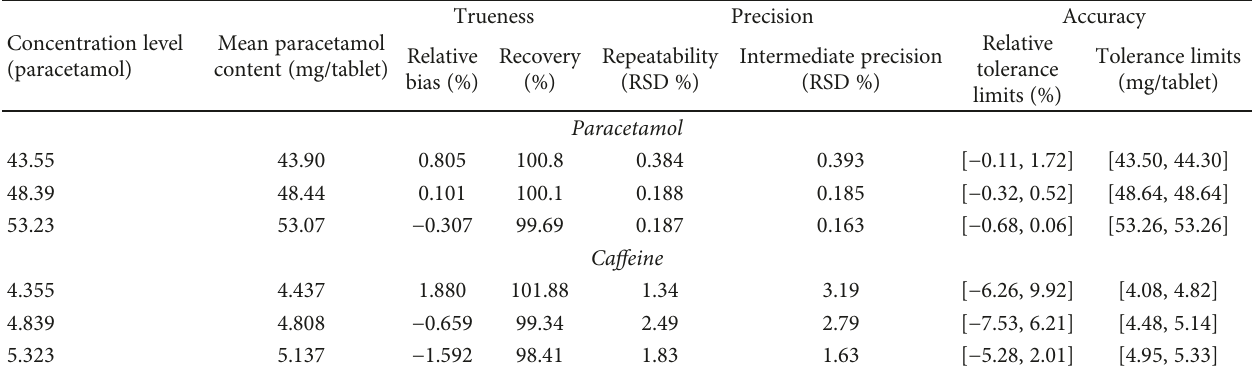
Table 4: Validation results of NIR method for paracetamol and ca ff eine assays in powder